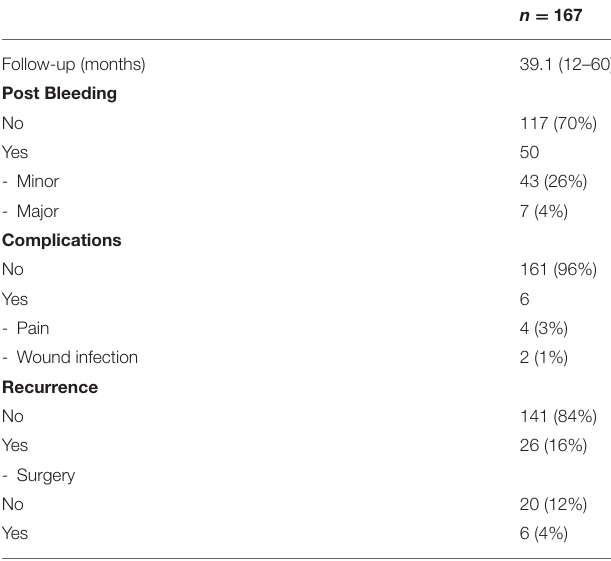
TABLE 2 | Postoperative complications and recurrence